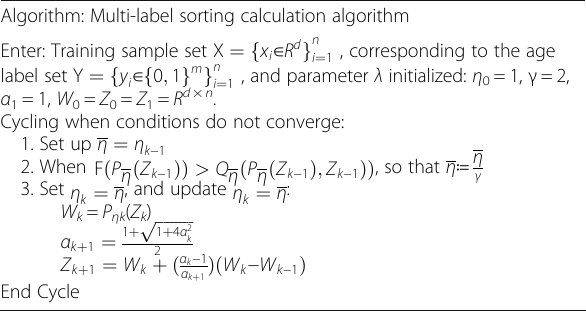
Algorithm: Multi-label sorting calculation